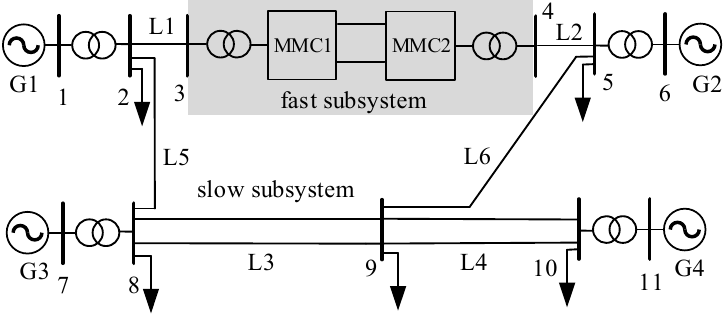
Figure 7. The four-machine AC/DC hybrid system.